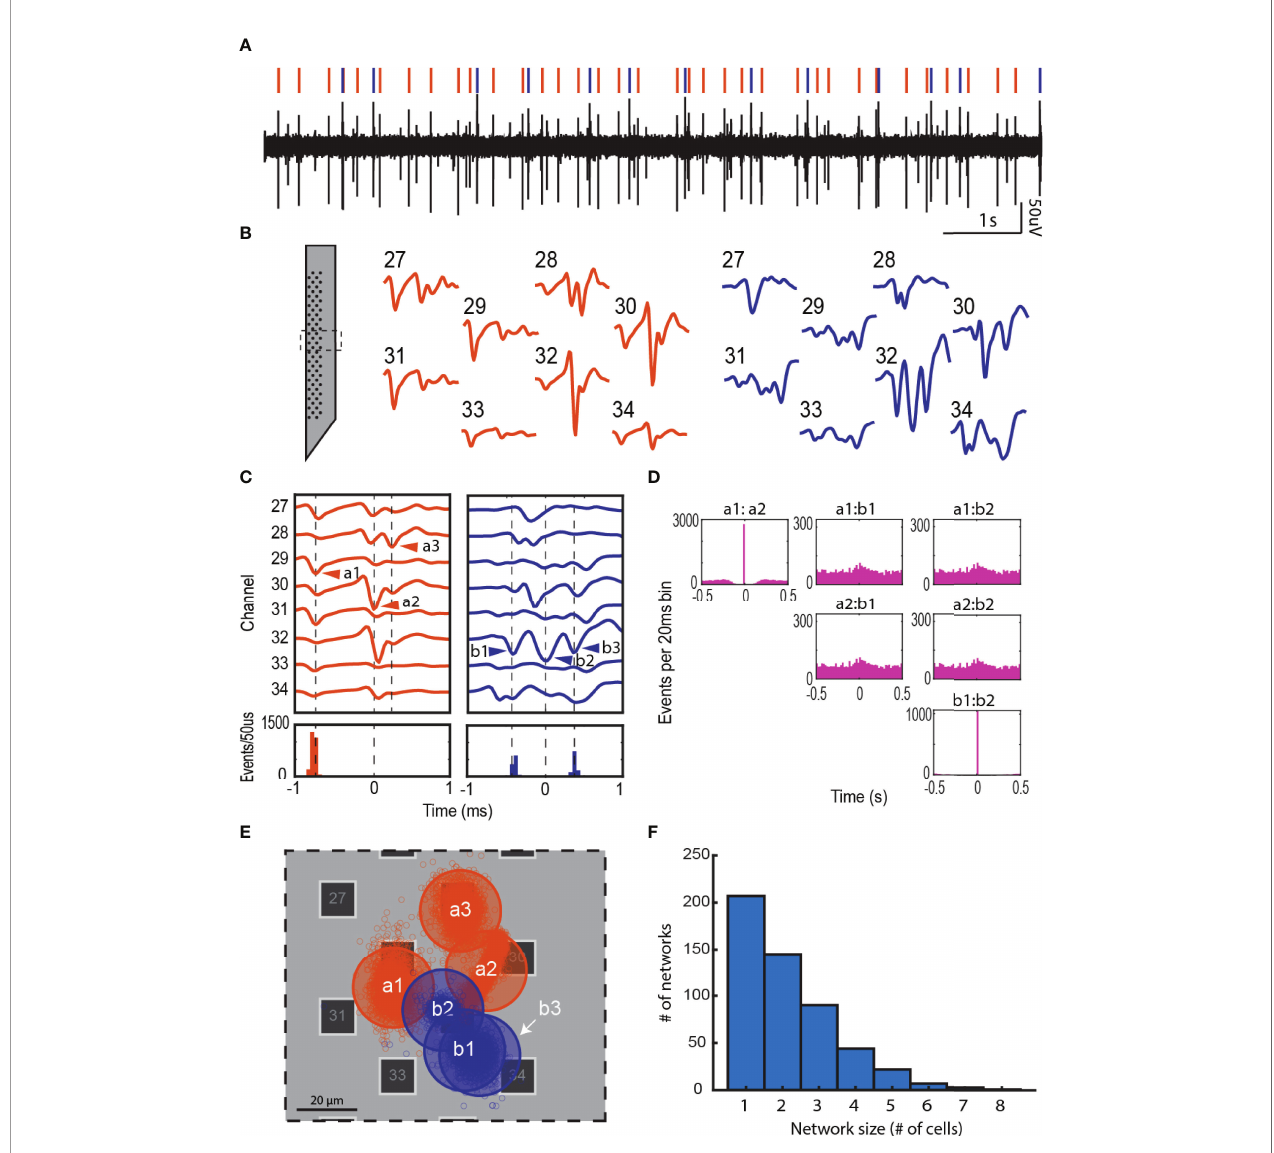
FIGURE 3 | Local network activity in the adrenal medulla. (A) Single channel recording showing multiple spikes (downward de fl ections). (B) Waveforms from multiple electrodes from the experiment in panel A were sorted to derive two distinct templates shown in orange and blue. The corresponding waveforms in the single channel recording in panel A are indicated by orange and blue vertical lines. The templates displayed complex waveforms comprised of multiple spikes occurring in fi xed succession. (C) Some of these spikes were identi fi ed as units on their own by the sorting algorithm (e.g. a1 and a2, and b1, b2 and b3), and others were manually identi fi ed from other templates derived from another unit (e.g. a3). A temporal histogram aligned to the reference unit in the template (time = 0 ms), shows a precise fi ring pattern of the units (a3 was excluded from this analysis). (D) A lower time resolution temporal histogram (20 ms per bin) shows a 1 to 1 correlation between a1:a2 and b1:b2, but no correlation between a and b (the total number of events for each unit are: a1 = 2818, a2 = 2875, b1 = 1061 and b2 = 1061). (E) Shows the approximate location of the cells associated with each network in (C) The small empty circles represent the result of the triangulation calculation for each action potential the cell fi red. Transparent large circles represent 20 µm diameter cells centered at the centroids of the clouds of points associated with a particular unit. (F) Network size distribution from a total of 40